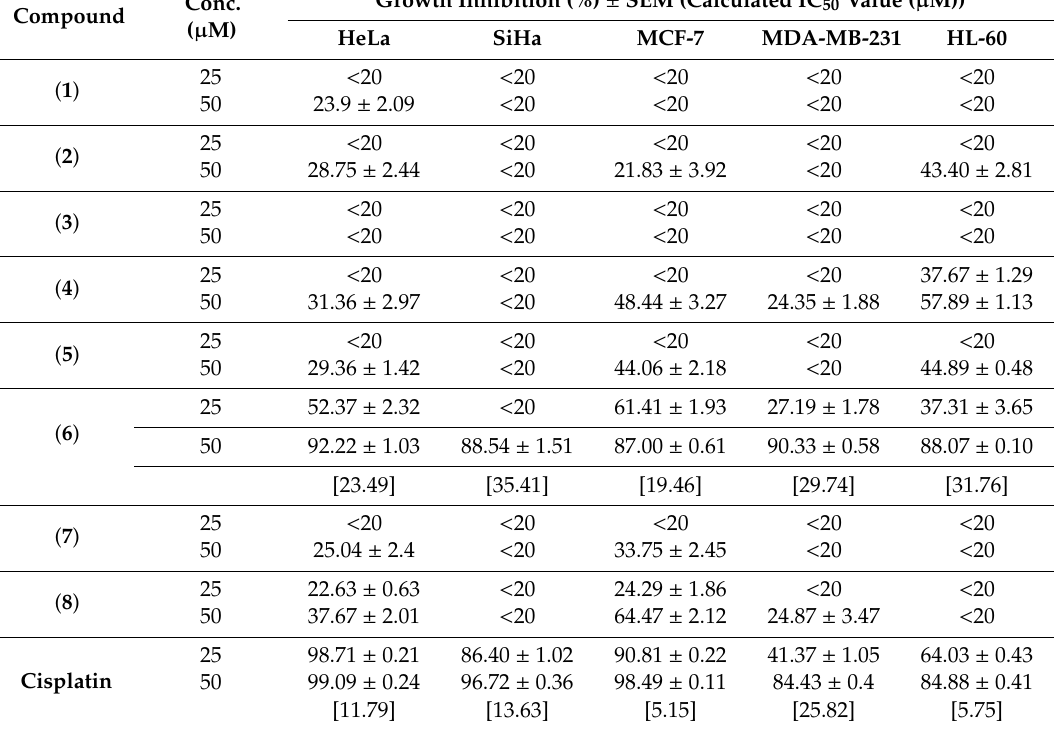
Table 1. Antiproliferative activities of naringenin and its oxime derivatives against four human gynecological cancer cell lines and HL-60 leukemia cells. Cisplatin was used as positive control; SEM: standard error of the mean; n =